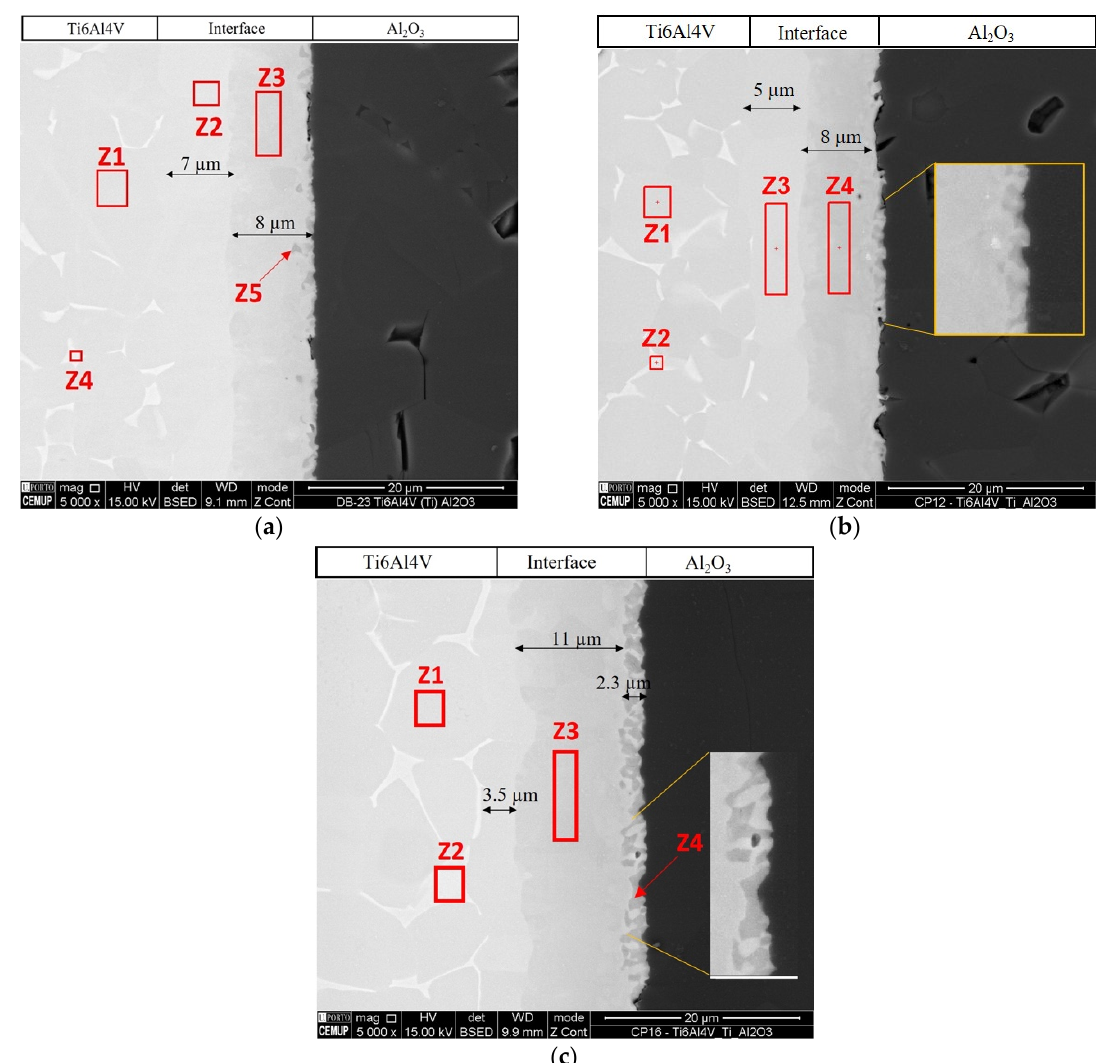
Figure 6. SEM images of the joints with Ti thin film interlayer processed at ( a ) 950 °C for 60 min, ( b ) 1000 °C for 10 min, and ( c ) 1000 °C for 60 min.